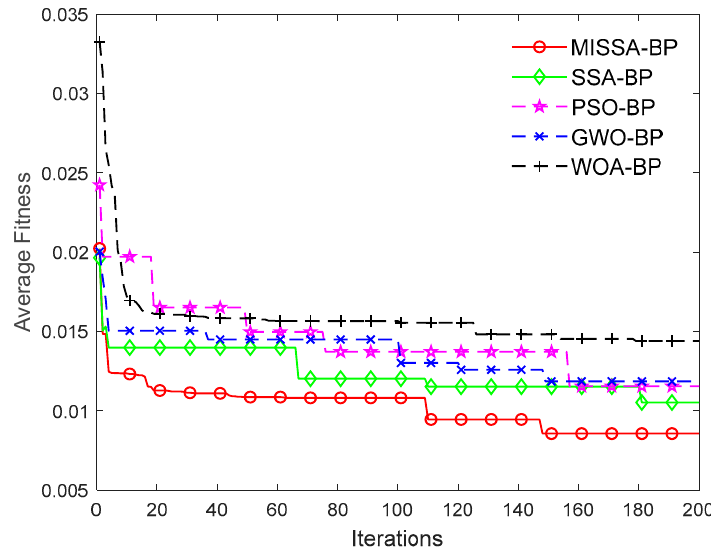
Figure 10. Iteration curve of the average fitness of the surrogate model.